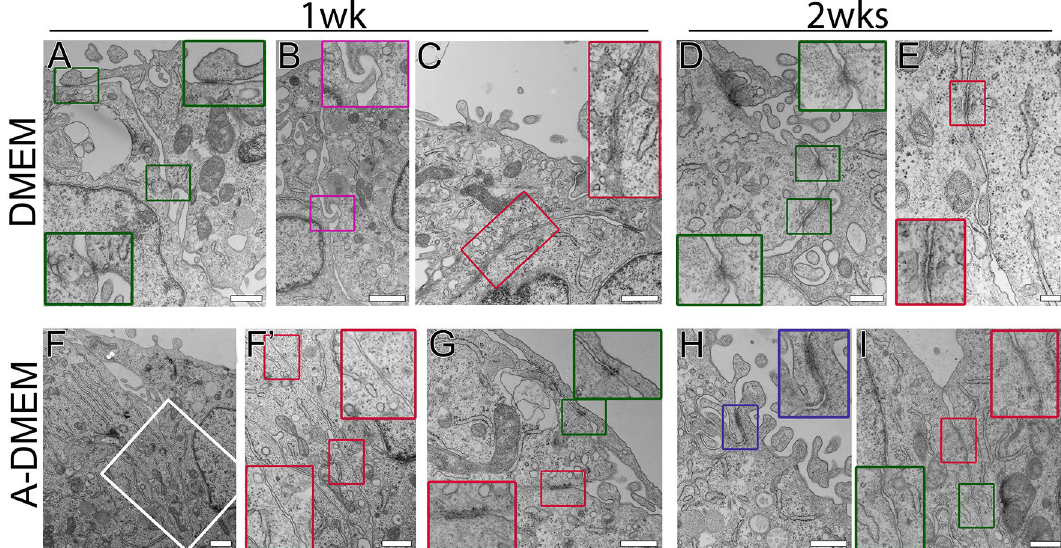
Figure 12. Ultrastructure of FLO-1 cells cultured in submerged conditions and maintained in DMEM or A-DMEM for 1 and 2 wks and analyzed with high magnification TEM. Cells are connected by protrusions (purple insets, B ), anchoring junctions (green insets, A , D , G , I ), adherent junctions and desmosomes (red insets, C , E , F ’, G , I ) and immature tight junctions (blue inset, H ). Cells maintained in A-DMEM are more frequently attached via adherent and tight junctions as cells maintained in DMEM. Large insets framed with green / red/ purple/blue lines are 100% enlarged images of corresponding small green/ red/purple/blue framed insets. The white boxed area in image F is shown in the magnified view in image F ’. Scale bar, 1 µm ( B , F ) 600 nm ( A , C , F ’, G , H , I ), 400 nm ( D ), 200 nm ( E